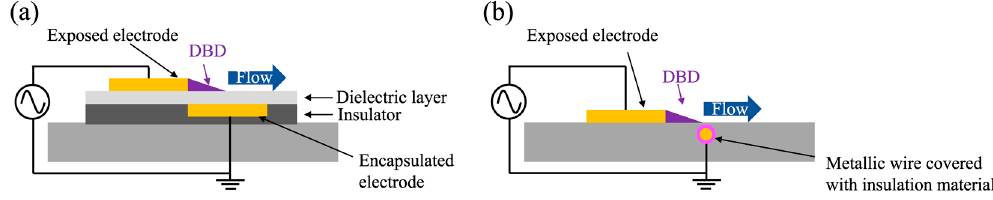
Figure 1. Schematic images of ( a ) sheet-type plasma actuator (PA) and ( b ) string-type PA.